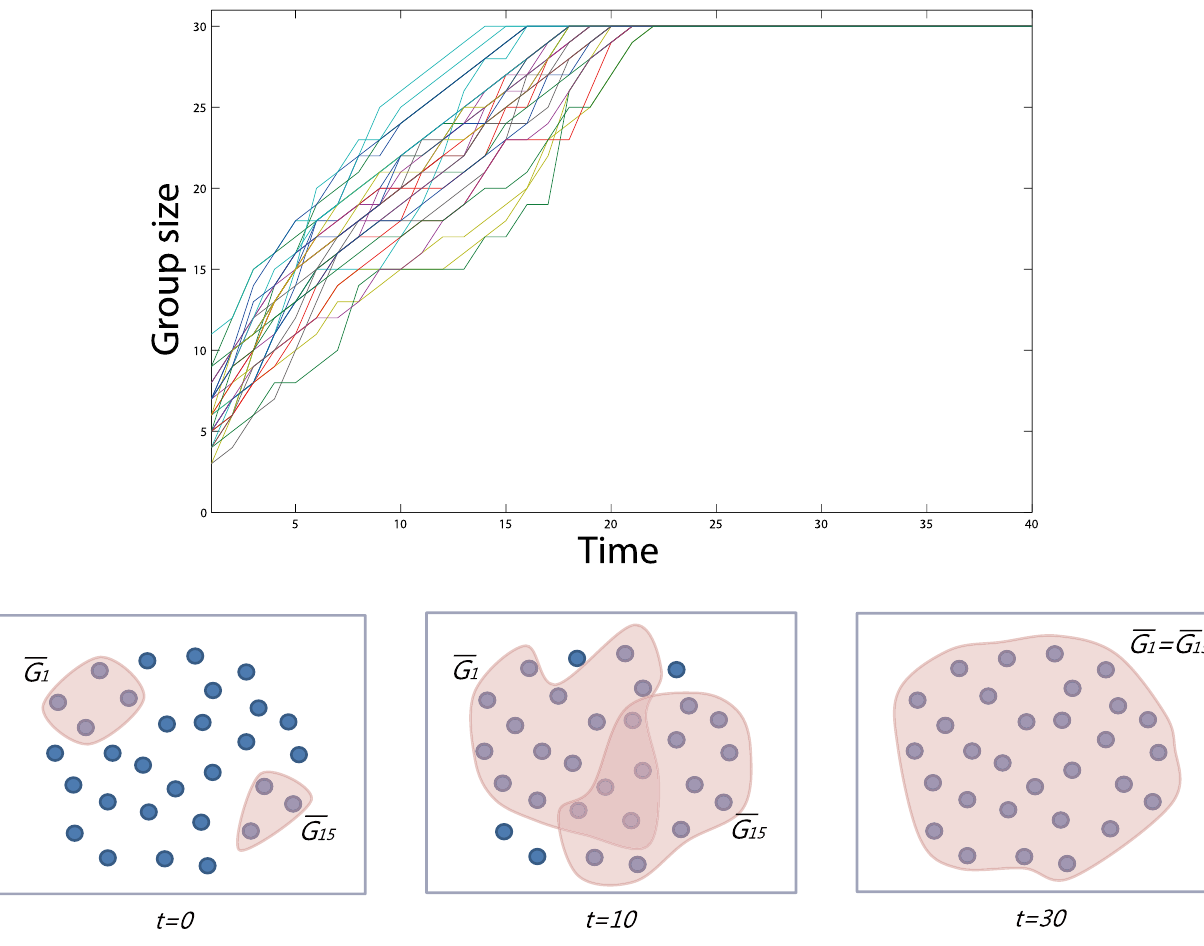
Figure 2. Evolution of the group sizes (upper) and the group formation. Two exemplary groups are illustrated below. The initial ratio of friendliness is 0.4 and the parameter a =1 is used.